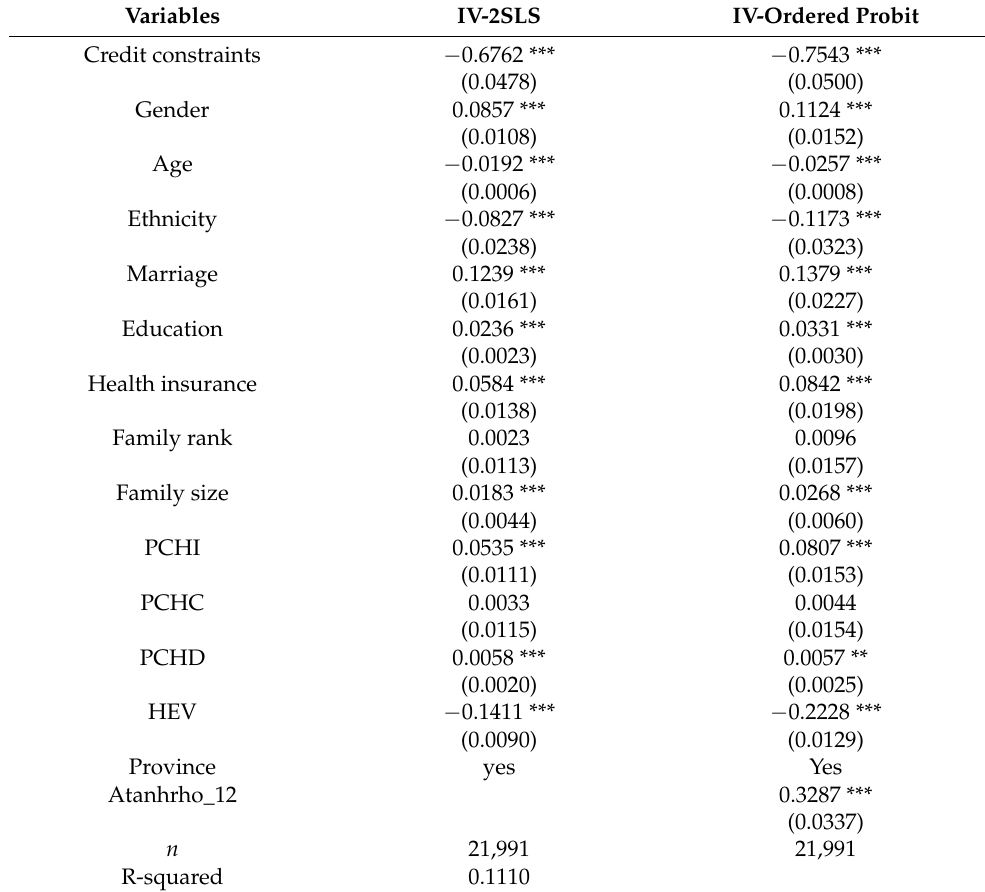
Table 3. Impact of formal credit constraints on rural residents’ self-rated health IV-2SLS and IV ordered probit